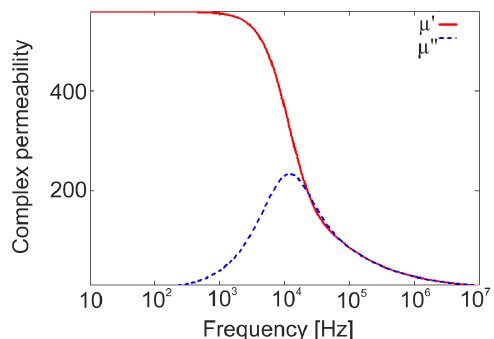
Figure 5. Complex permeability of the core material ( µ r = 560, γ = 2 · 10 6 S/m, 2 D = 0.23 mm) as a function of frequency.